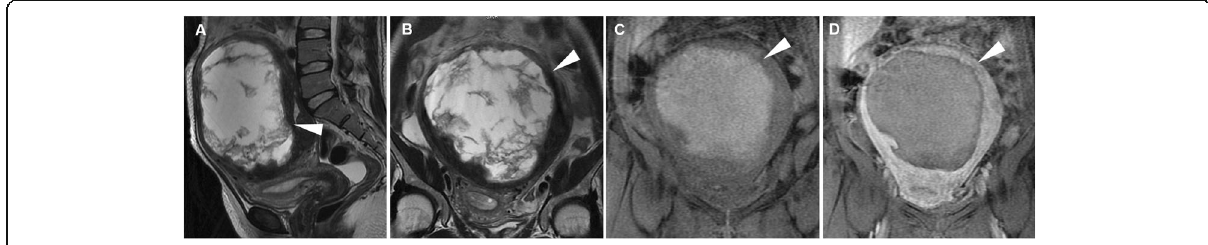
Fig. 5 Leiomyoma with haemorrhagic degeneration in a 37-year-old woman with a palpable abdominal mass, pelvic pain and fever. Sagittal ( a ) and oblique-coronal ( b ) T2-weighted images show a huge subserosal leiomyoma arising from the posterior wall of the uterus, with